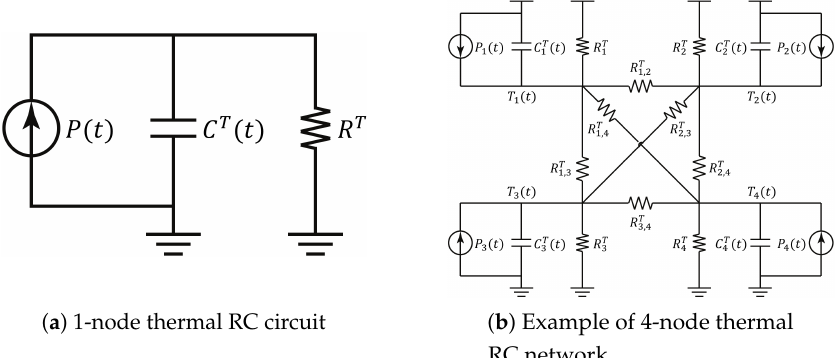
Figure 6. Conventional thermal RC (Resistor–Capacitor) circuit